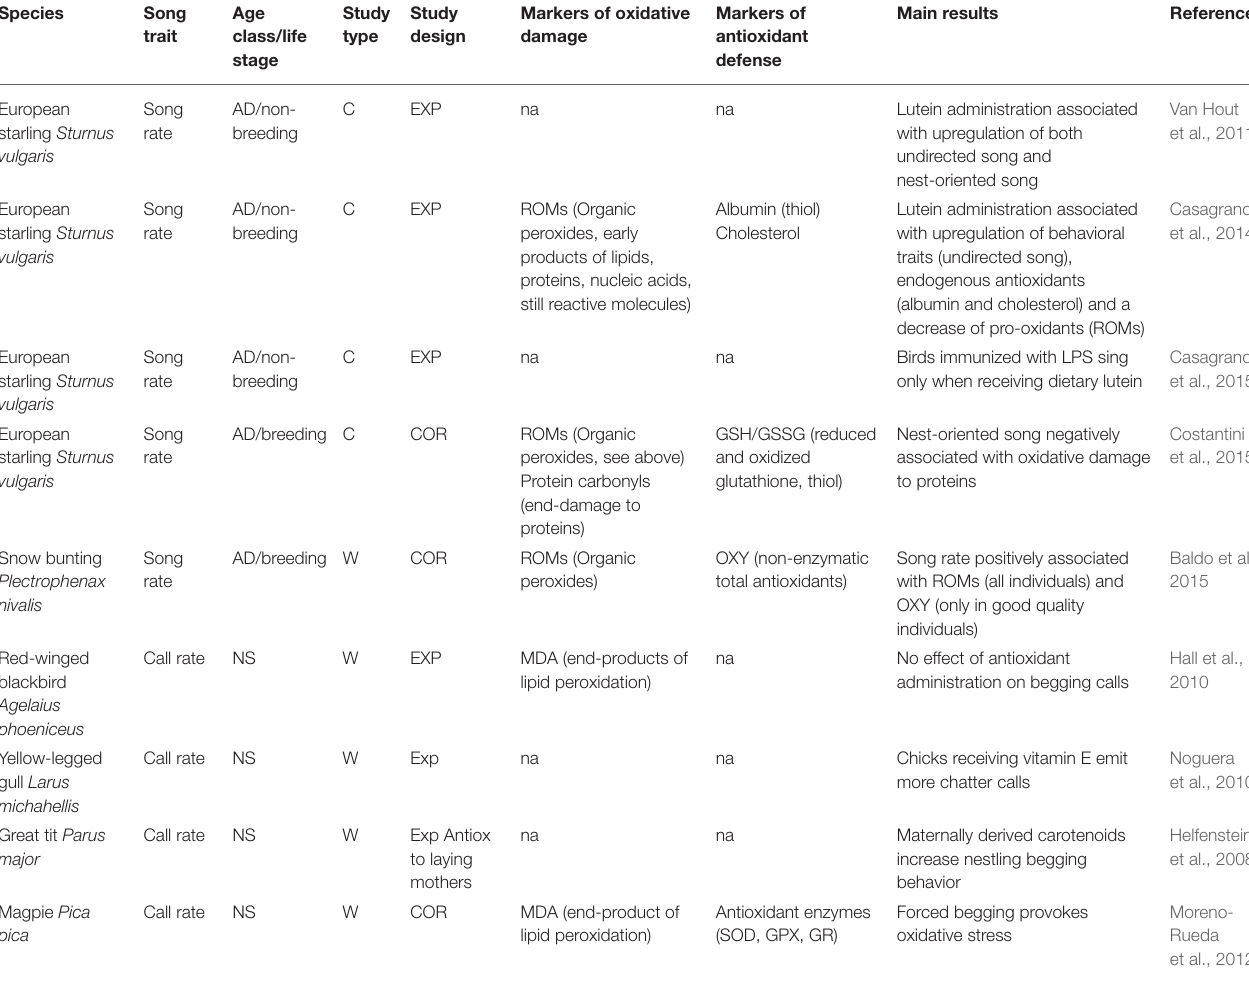
TABLE 1 | Review of existing literature on the relationships between song traits and oxidative stress.